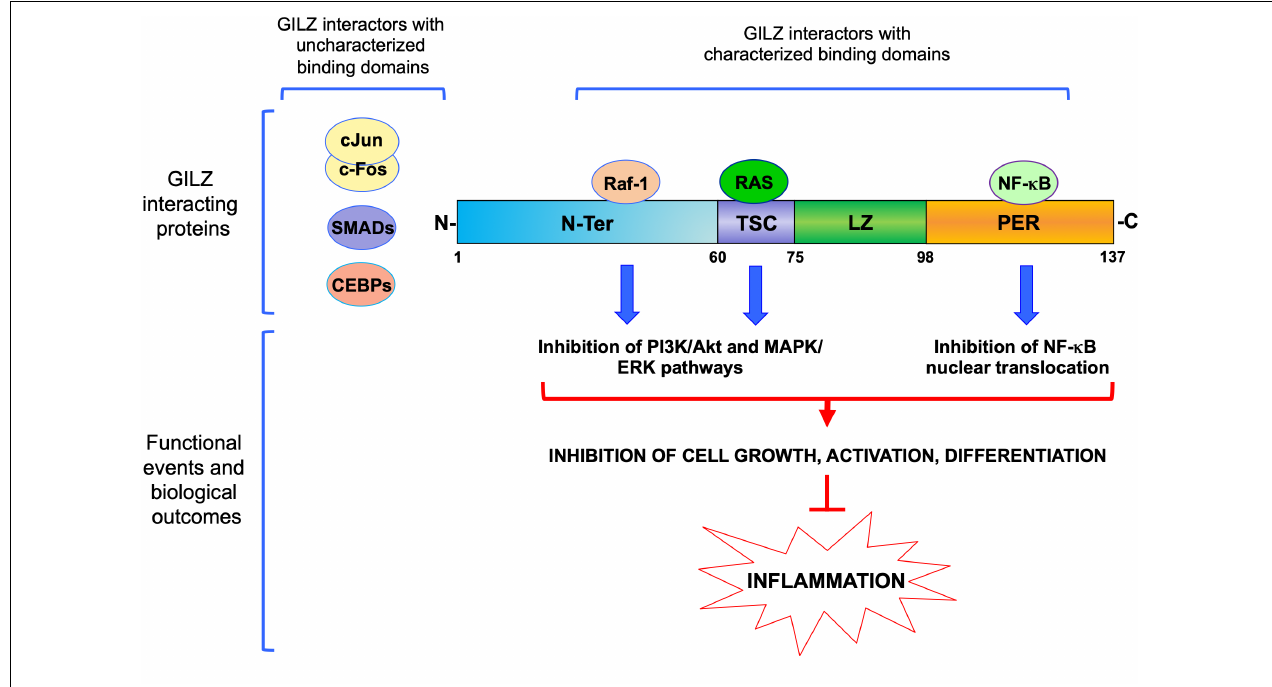
FIGURE 2 | Molecular interactions of GILZ in the control of inflammation. Schematic representation of GILZ’s protein and its functional domains: N-Ter, N-terminal region (1–60 amino acids); TSC, TGF- β stimulated clone box (61–75 amino acids); LZ, leucine zipper domain (76–97 amino acids); PER, proline (P) and glutamic acid (E) rich region (98–137 amino acids). Proteins with characterized region of interaction are represented above GILZ protein diagram or aside, when specific regions of interaction have not been characterized yet. Raf-1, Raf-1 Proto-Oncogene, Serine/Threonine Kinase; RAS, Ras Proto-Oncogene, GTPase; NF- κ B, nuclear factor kappa-light-chain-enhancer of activated B cells; cJun/cFos, proto-Oncogene components of an heterodimer also named Activator protein-1, AP-1; SMADs, Mothers against decapentaplegic homolog proteins; CEBPs, CCAAT-enhancer-binding